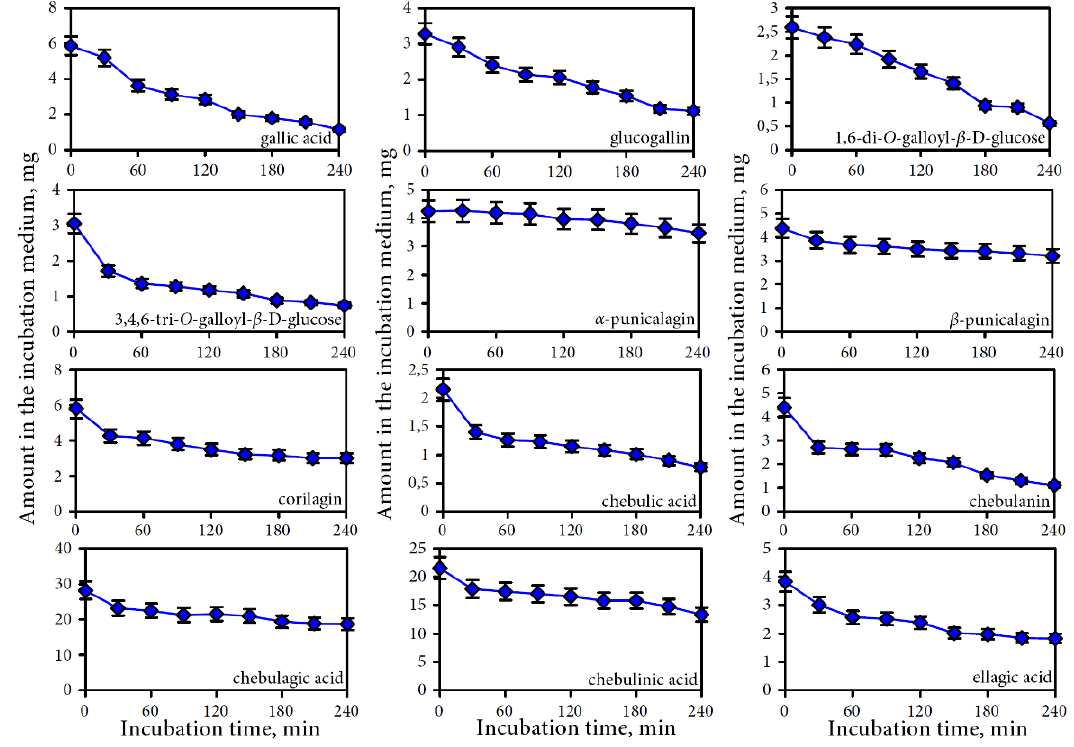
Figure 5. Dynamic of phenolic depletion of intestine media retentate during dialysis for separate compounds.